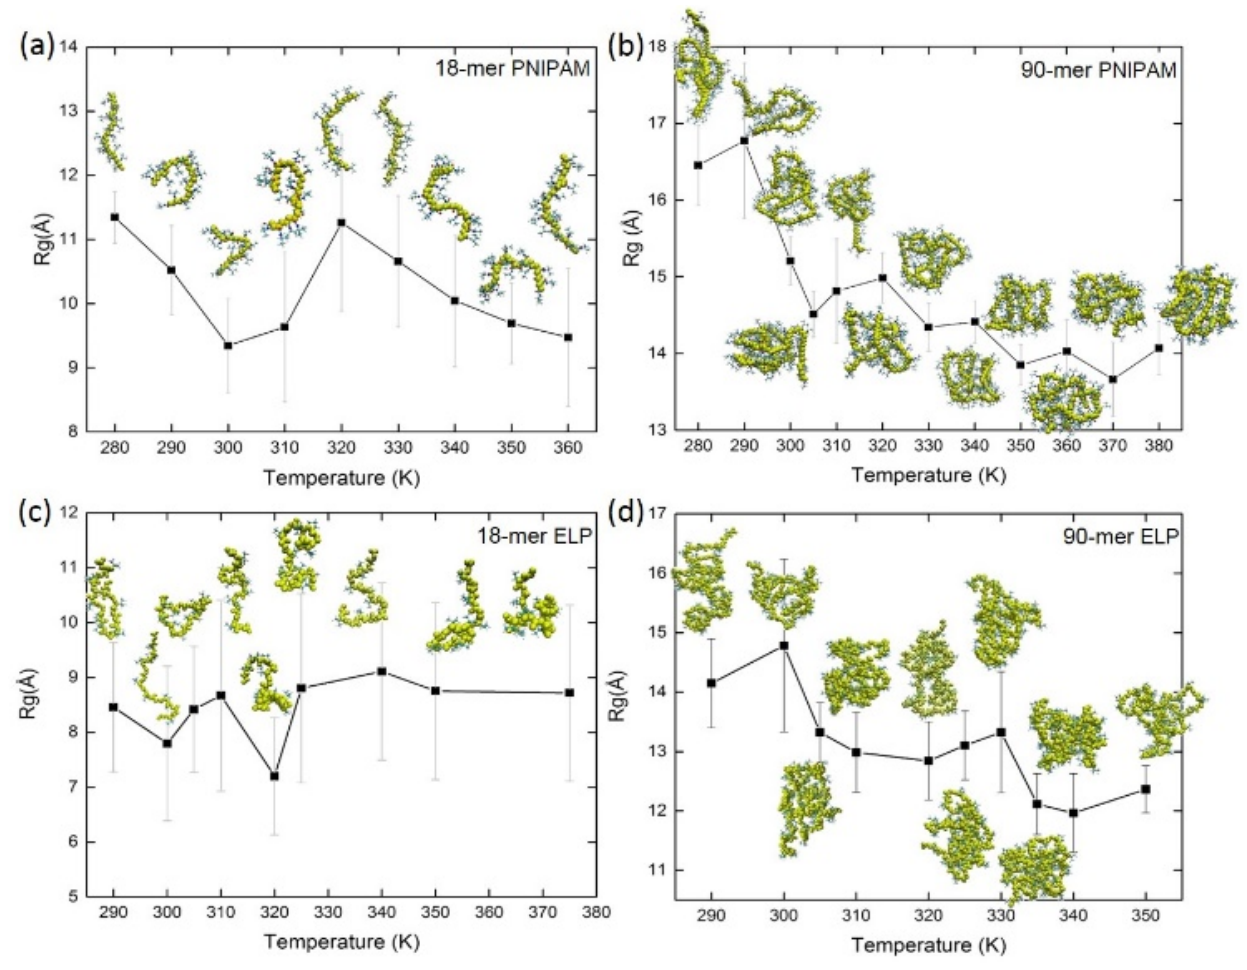
Figure 2. The radius of gyration and simulation snapshots as a function of temperature for PNIPAM ( a ) 18-mer and ( b ) 90-mer and ELPs ( c ) 18-mer and ( d ) 90-mer.